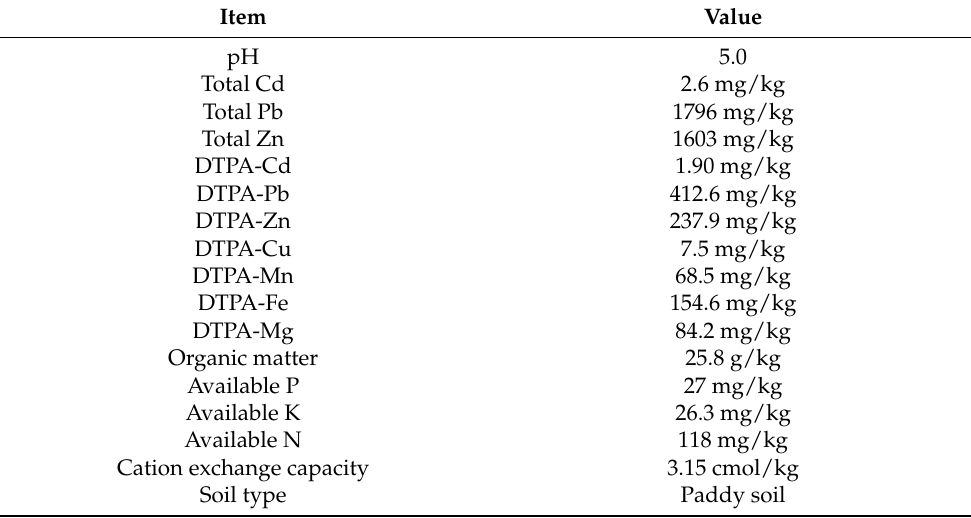
Table 1. The physiochemical properties of the